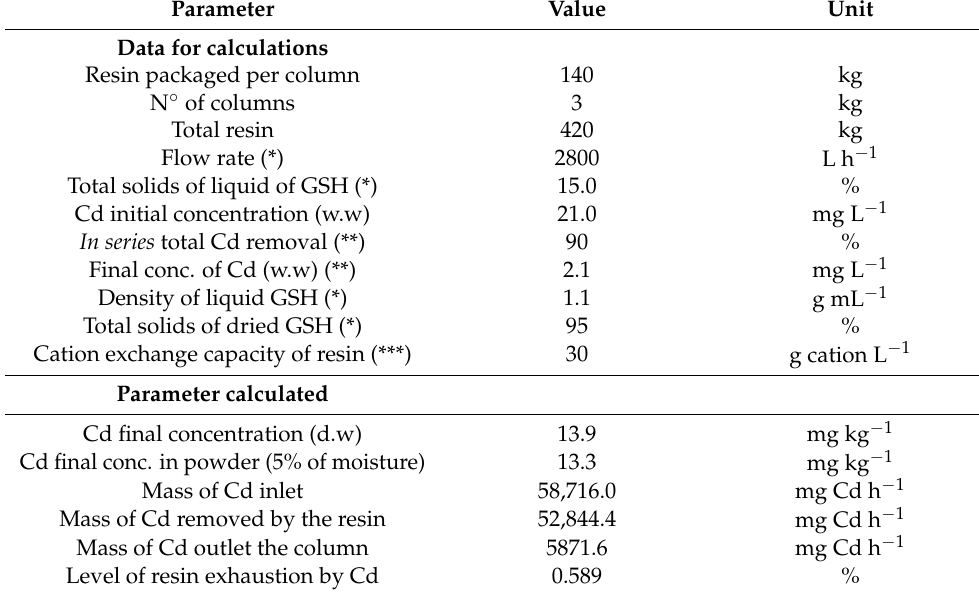
Table 6. Data analysis of cadmium removal using 3 columns connected in series for scaling up a real process. A cadmium concentration in the GSH of 20.97 mg · L − 1 and a flow rate of 2800 L h − 1 (average from the fishing plant) were